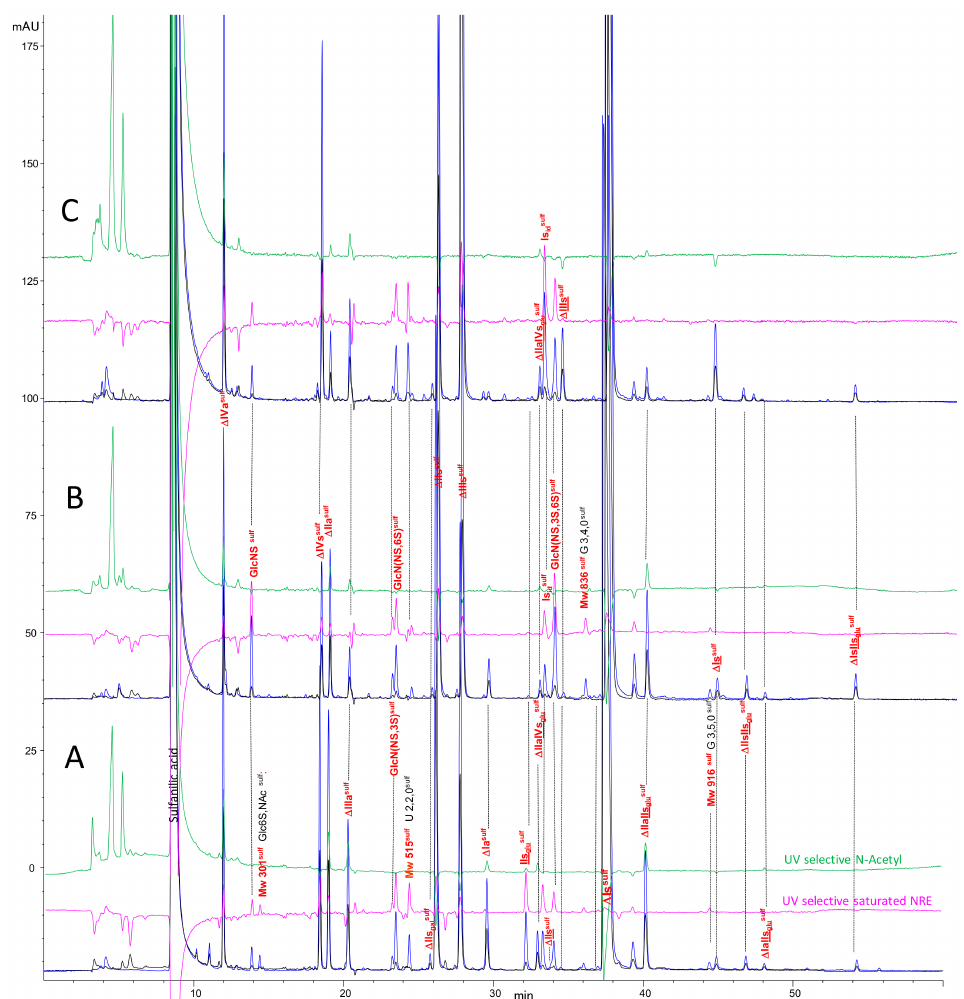
Figure 9. Chromatogram on AS11 (two columns) of heparin digests ( A ) PMH, ( B ) OMH, ( C ) BMH with sulfanilic tagging. Detection: — 265 nm; — 232 nm; — 265 nm – 2.2 × 232 nm; — (200–242 nm) − 0.74 × 265 nm Peak assignment: IIs glusulf